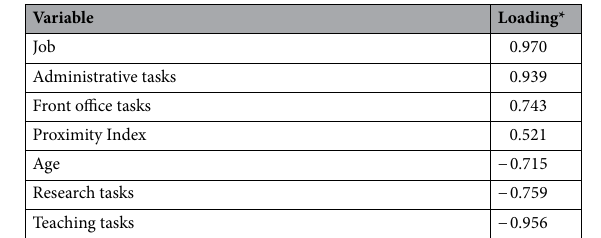
Table 3. Variables loading with absolute values ≥ ± 0.4 on the first principal component (variance accounted for 13%), the only one showing significance as a predictor of PWBI in the regression analysis. *Index of the correlation of the original variables with the first principal component.